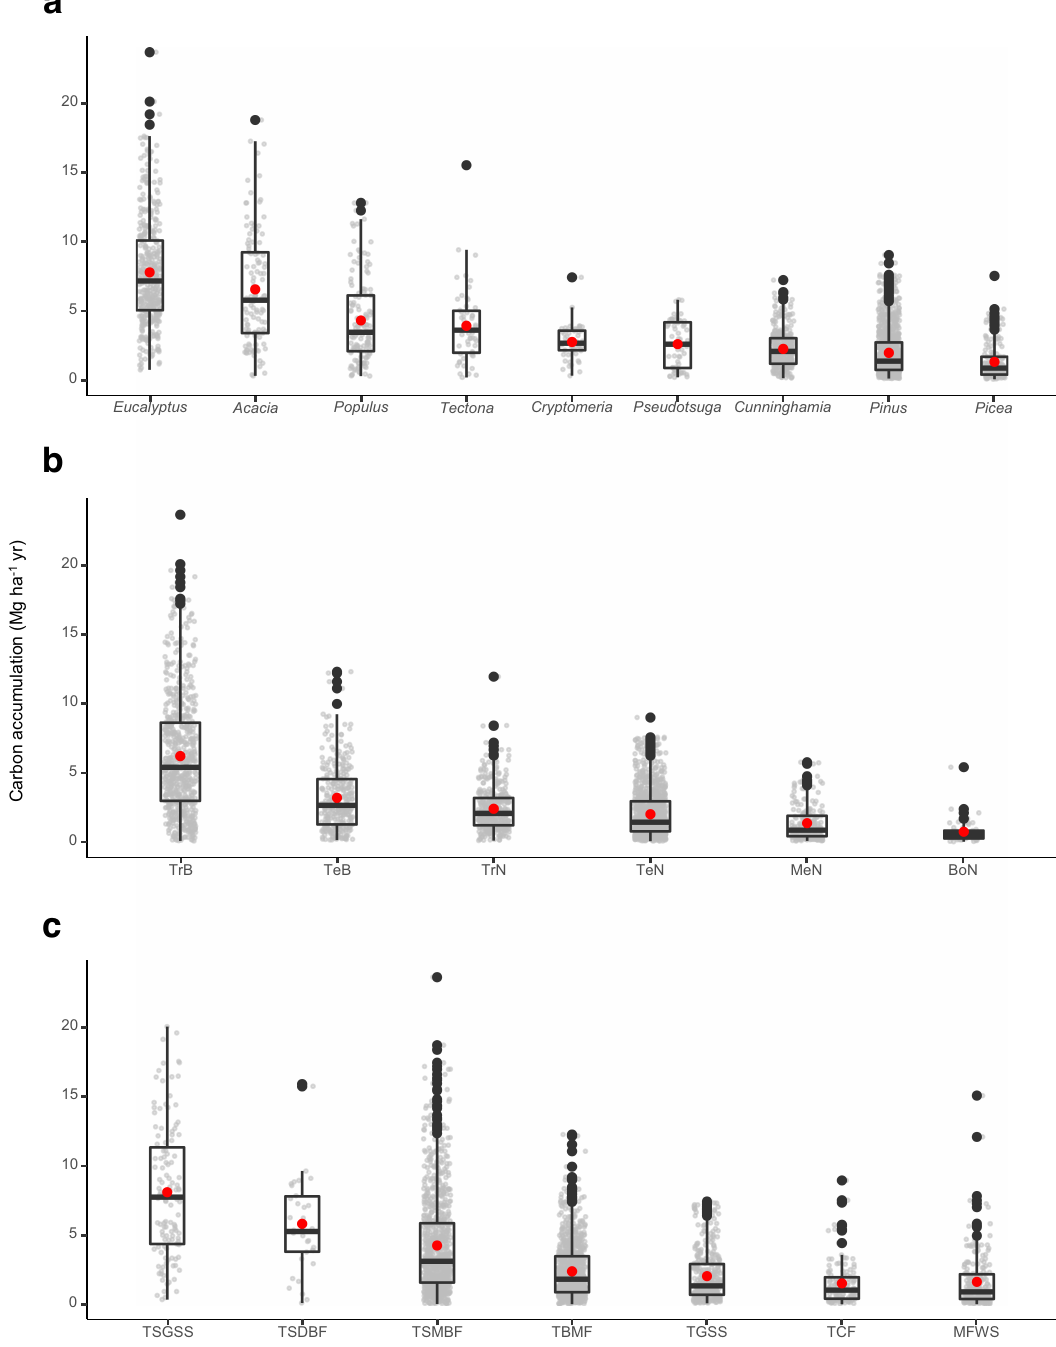
Fig. 6 Annualized aboveground carbon accumulation. Annualized aboveground carbon accumulation rates for the major ( a ) genera, ( b ) plant functional types, and ( c ) biomes. Plant functional type codes: TrB – tropical broadleaf; TeB – temperate broadleaf; TrN – tropical needleleaf; TeN – temperate needleleaf; MeN – Mediterranean needleleaf; BoN – boreal needleleaf. Biome codes: TSGSS – tropical & subtropical grasslands, savannas, and shrublands; TSDBF – tropical & subtropical dry broadleaf forests; TSMBF – tropical & subtropical moist broadleaf forests; TBMF – temperate broadleaf & mixed forests; MFWS – Mediterranean forests, woodlands & scrub; TCF – temperate conifer forests; TGSS – temperate grasslands, savannas & shrublands. Boxplots indicate the median values and the 25th and 75th percentiles of the data, whereas the whiskers extend to values no further than 1.5 * the interquartile range. The red points represent mean values. The number of observations for each grouping are: Eucalyptus – 397; Acacia – 110; Populus – 132; Tectona – 54; Cryptomeria – 52; Pseudotsuga – 56; Cunninghamia – 321; Pinus – 1,072; Picea – 177; TrB – 656; TeB – 298; TrN – 374; TeN – 1,076; MeN – 213; BoN – 54; TSGSS – 123; TSDBF – 34; TSMBF – 879; TBMF – 929; TGSS – 346; TCF – 134; MFWS –